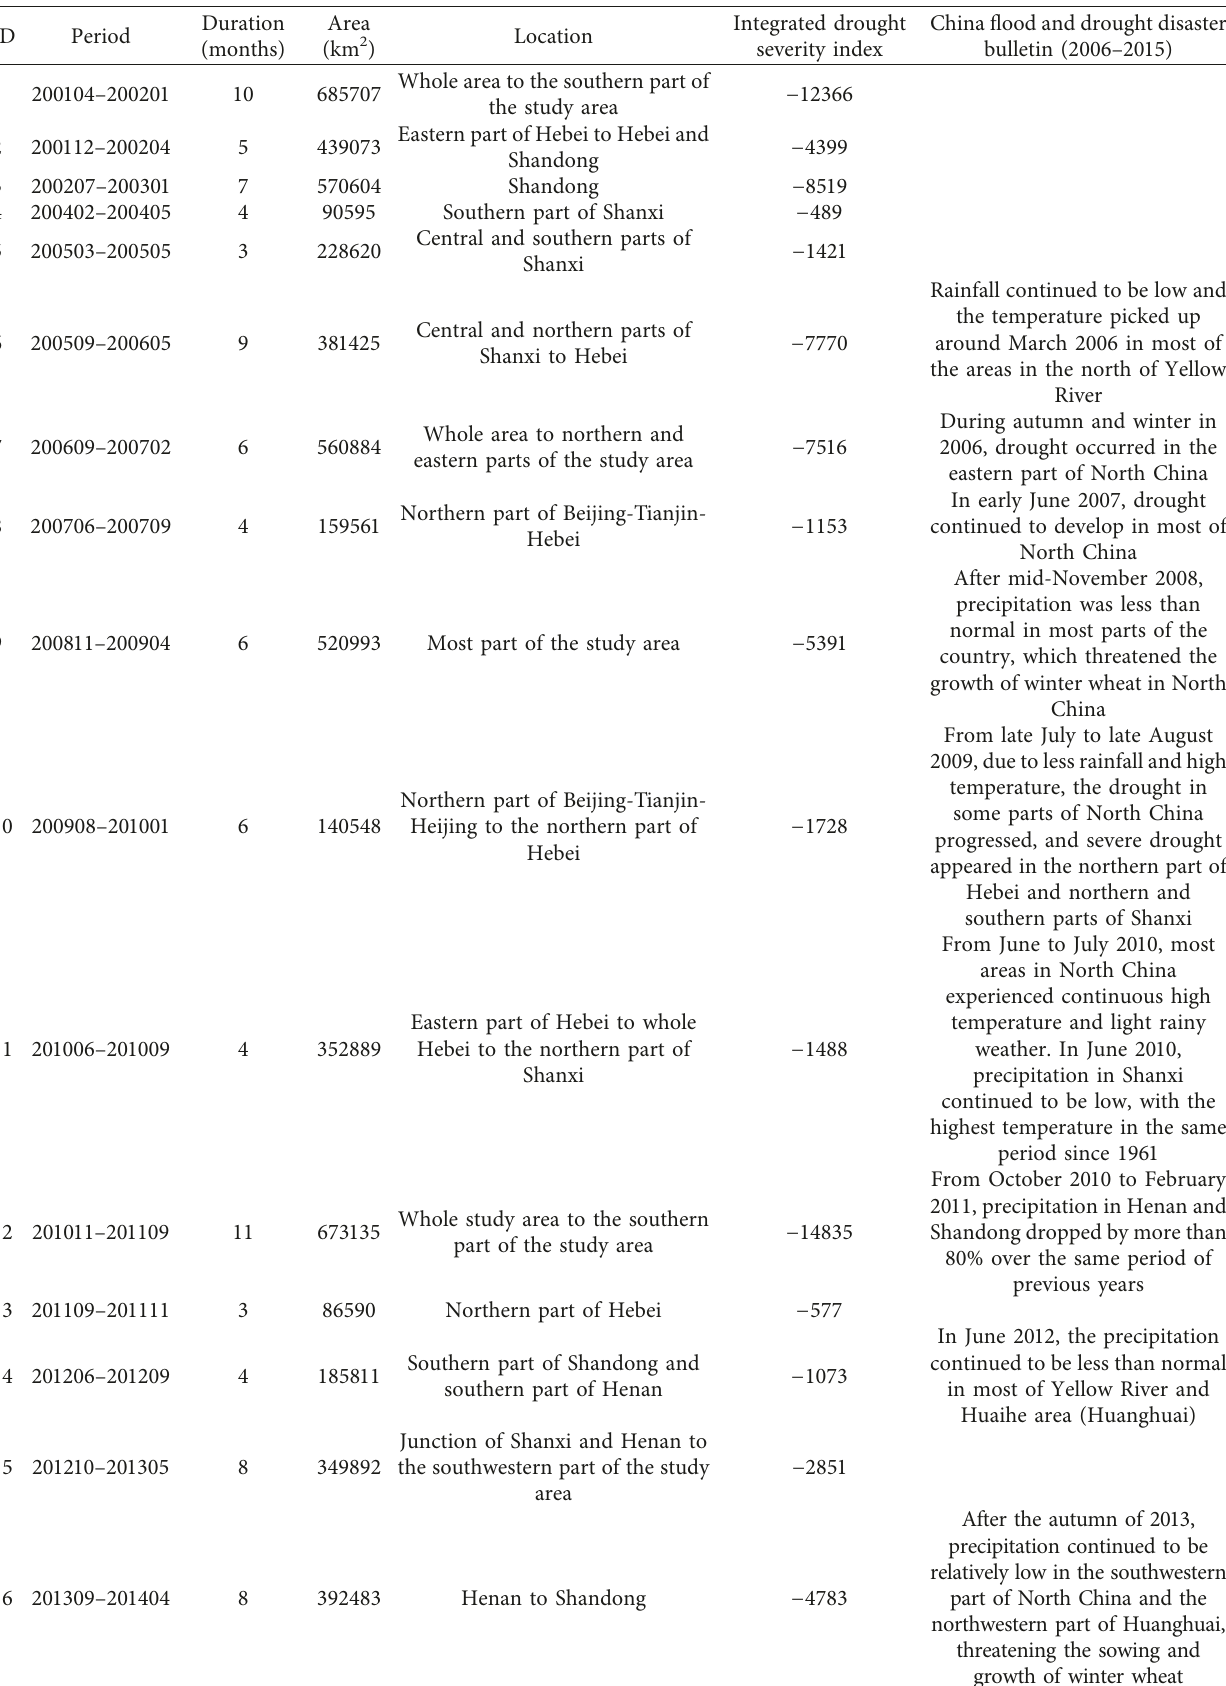
Table 2: Drought events in North China during